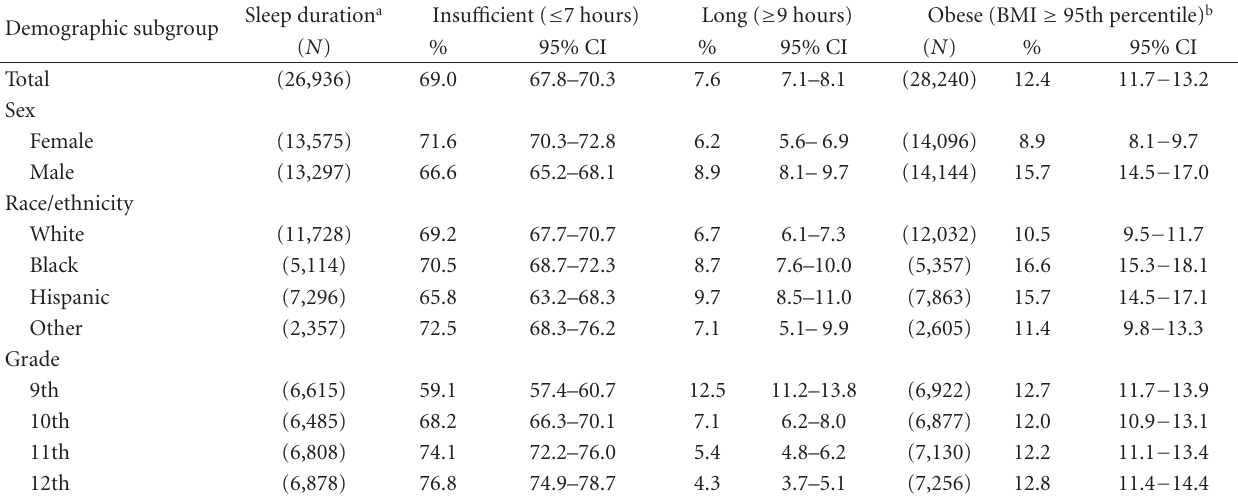
Table 1: Prevalence of insu ffi cient and long sleep duration and obesity—US high school students. Demographic